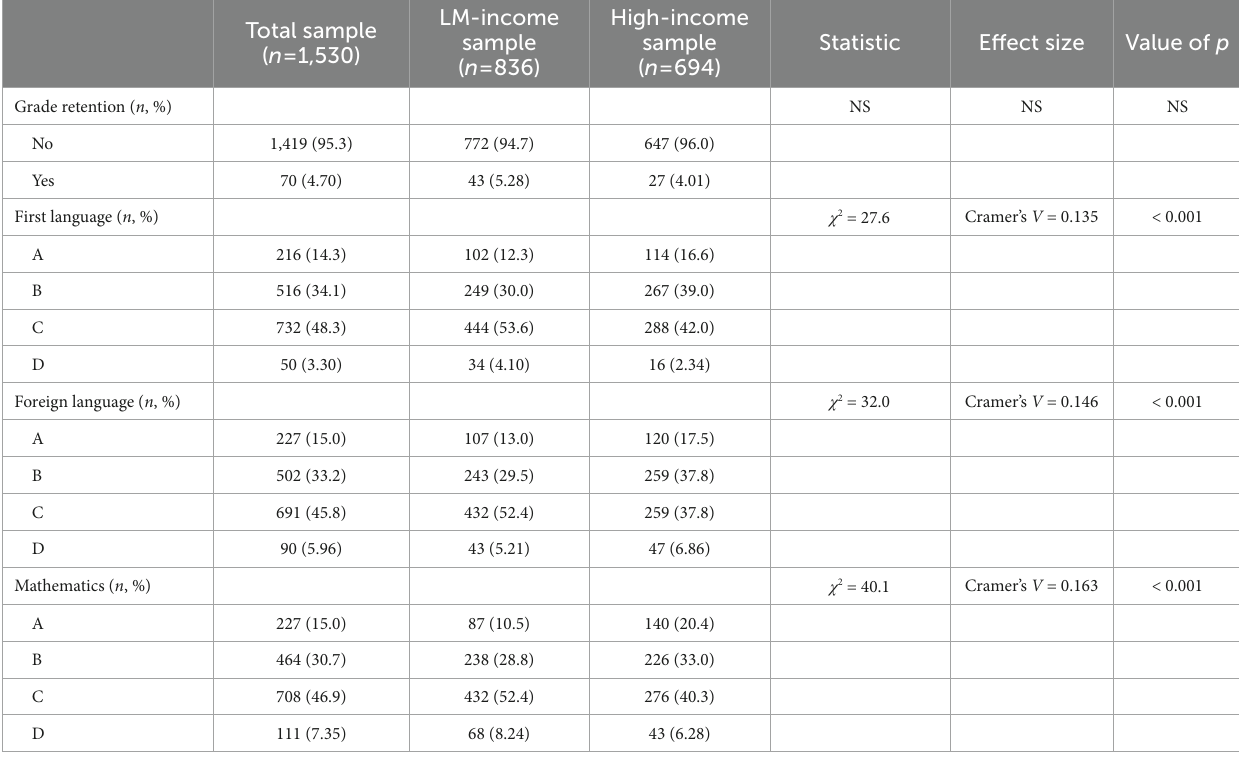
TABLE 3 Academic performance on first language, foreign language, and